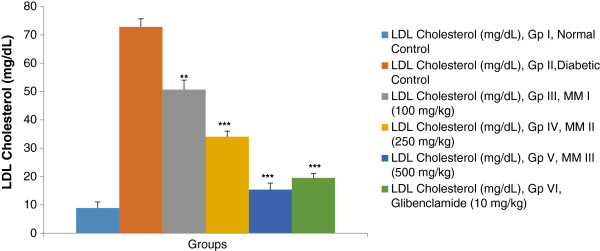
Effect of Melastoma malabathricum Linn. (MM) on level of LDL cholesterol at different concentrations on STZ induced diabetic rats, compared to standard drug Glibenclamide; values are mean ± SEM; n = 6; *P < 0.05; **P < 0.01; ***P < 0.001; P > 0.05 is considered as non-significant (ns).